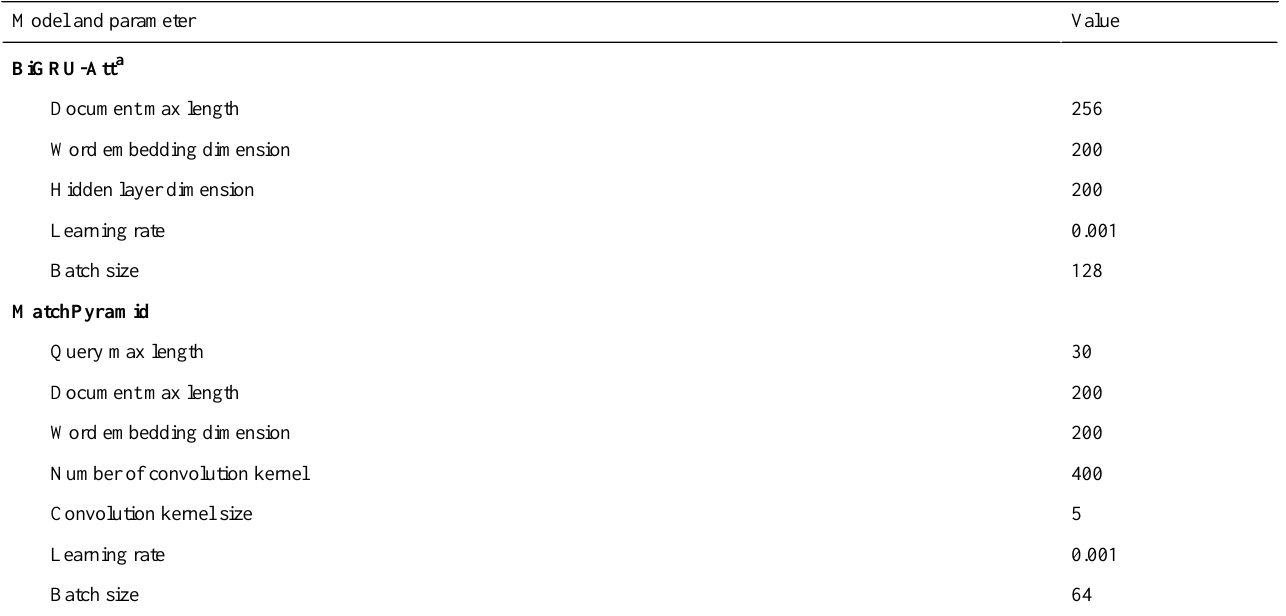
Table 1. The hyperparameters of BiGRU-Att and